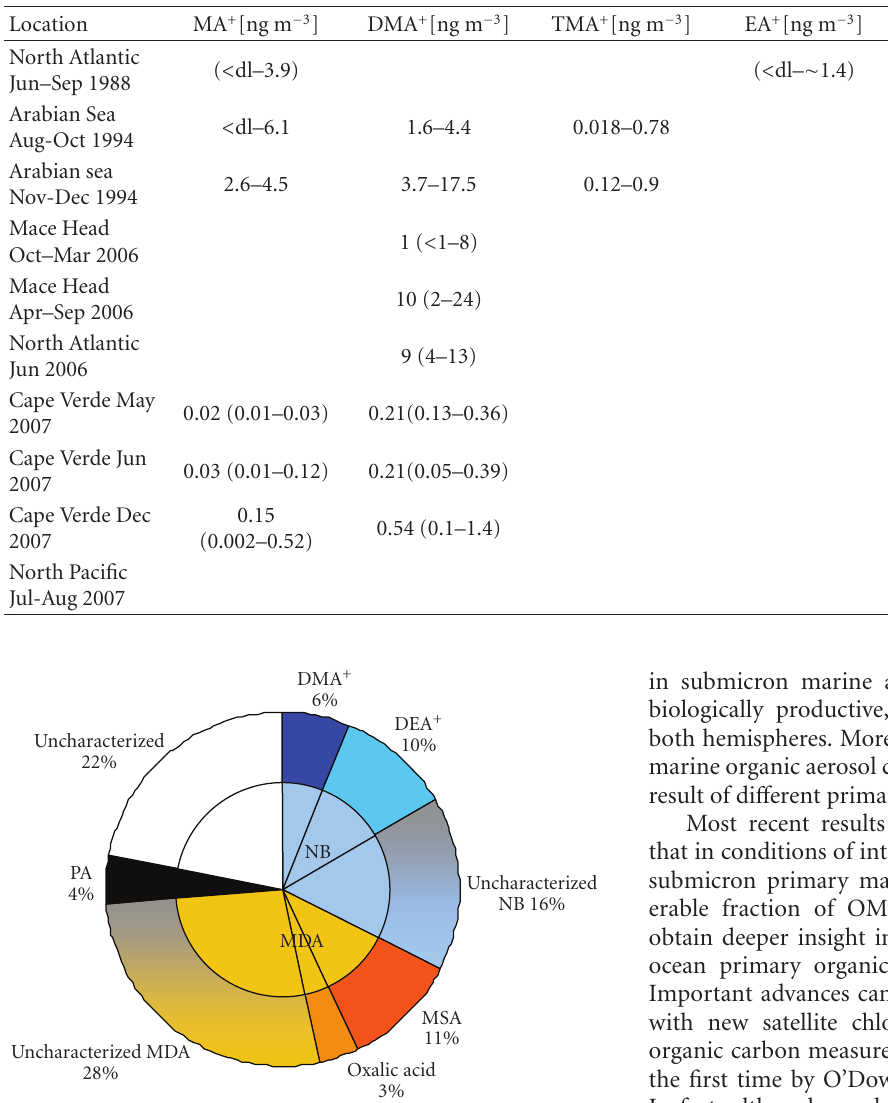
Table 3: Alkylammonium ions aerosol concentration range (in brackets) and median value (when available) reported in the literature for the marine environment. All concentrations are in ng m − 3 . All data refer to submicron particles except for M¨uller et al. [51], whose size cut was 0.14–0.42 μ m, and Gorzelska and Galloway [44], who did not report any particle size information.